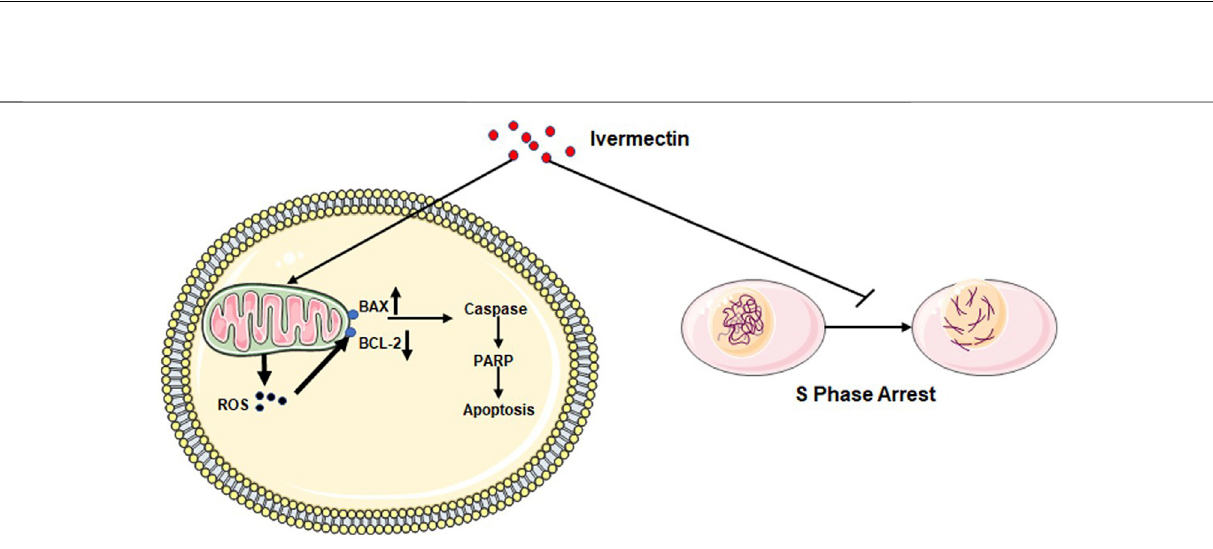
Frontiers in Pharmacology |